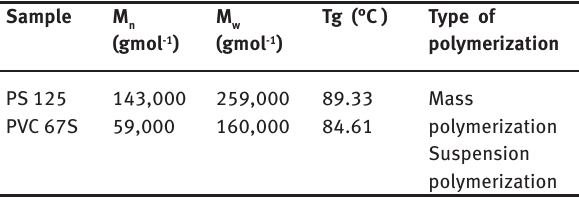
Table 1: Molecular weight and glass transition temperature of PS and PVC.